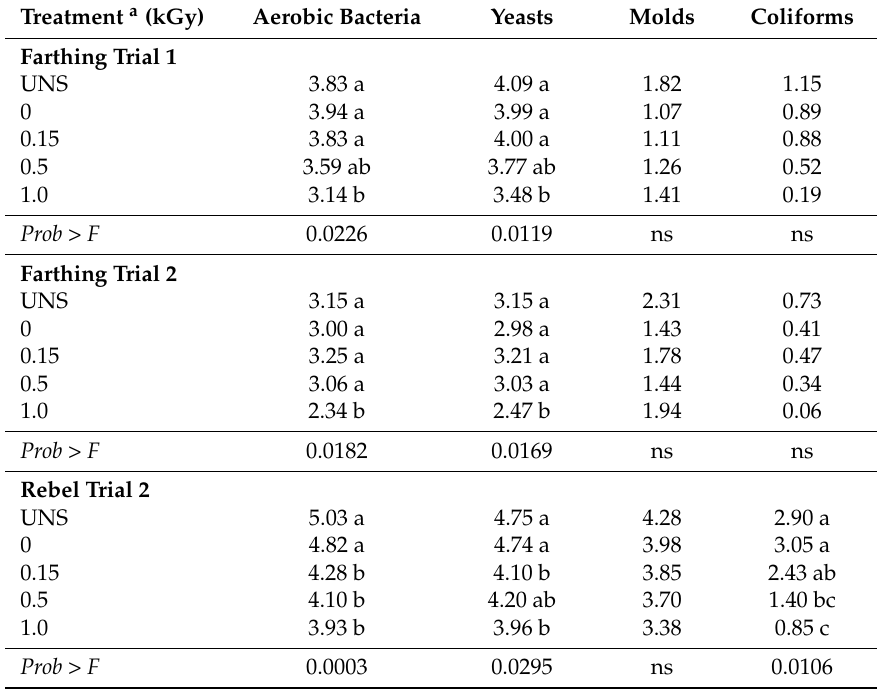
Table 3. Surface microbial load, in log (colony-forming units per g of fruit), on ‘Farthing’ and ‘Rebel’ blueberry fruit subjected to Electronic Cold-Pasteurization TM 6 days after